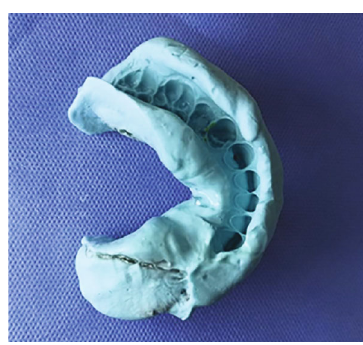
Figure 6: Final impression.